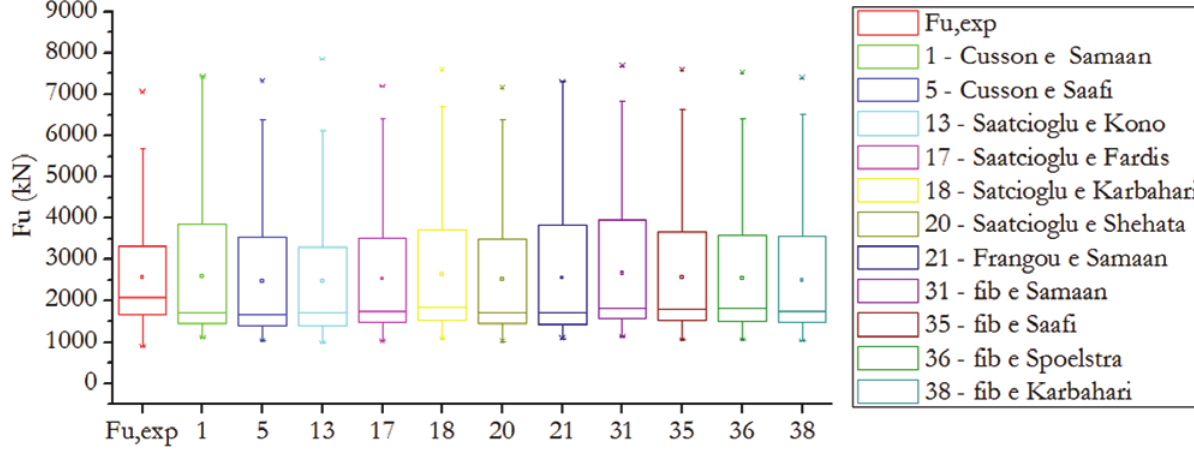
Variabilidade dos modelos de confinamento com PRF e armadura transversal em relação aos valores